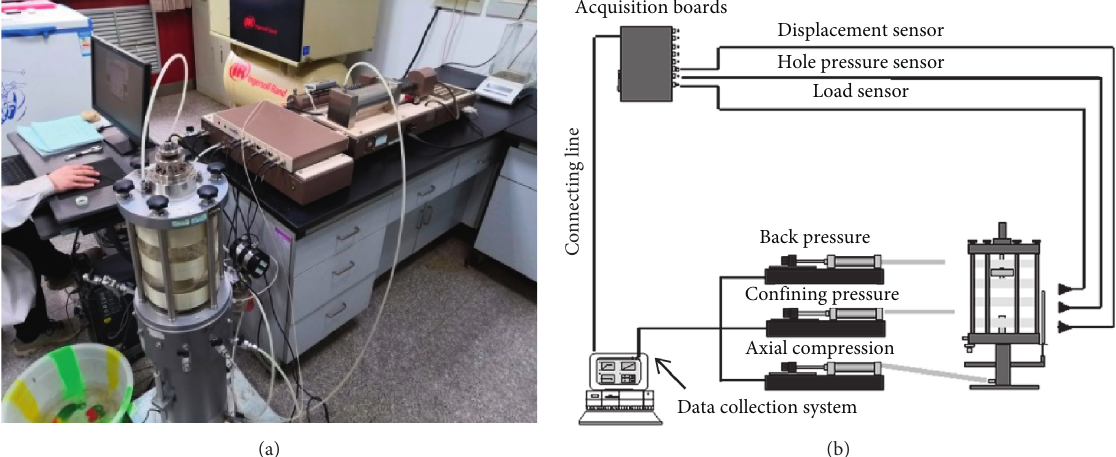
Figure 2: Triaxial test equipment used in this study (a) and its schematic diagram